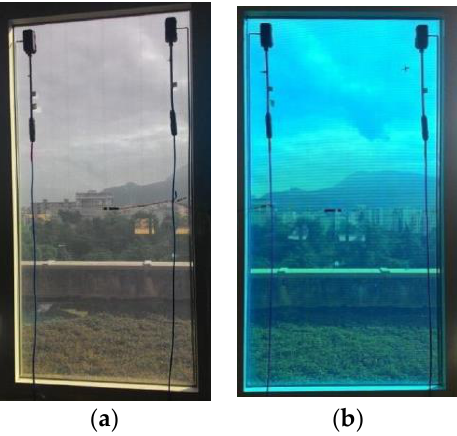
Figure 9. PV wall system based on a-Si: Grey cell ( a ), Blue cell ( b ) (both made by Onyx solar).